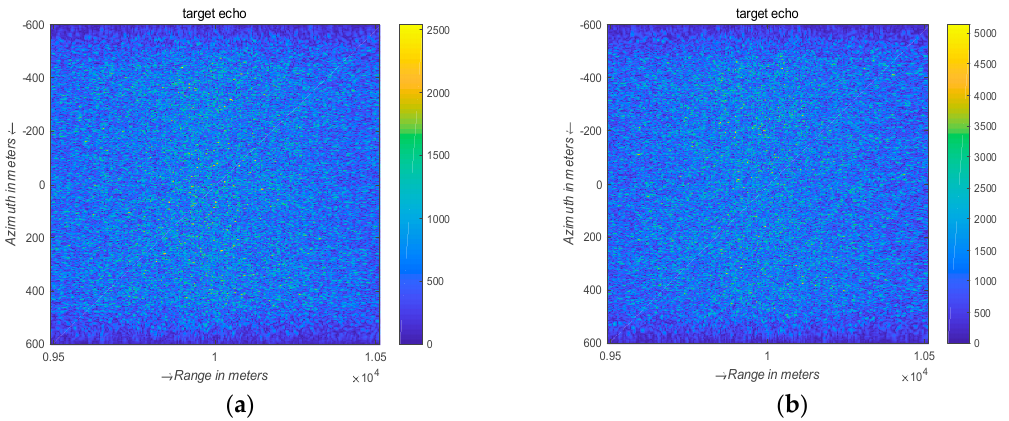
Figure 5. Ocean surface echo signals as follows: ( a ) wind speed of 10 m/s and ( b ) wind speed of 15 m/s.